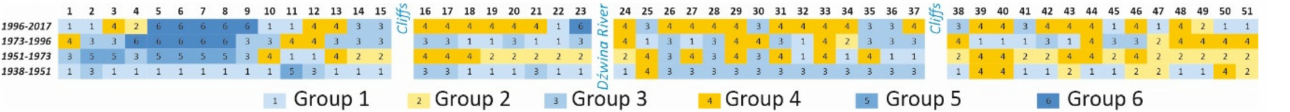
Figure 10. Areas in Groups 1–6 classified according to Ward’s